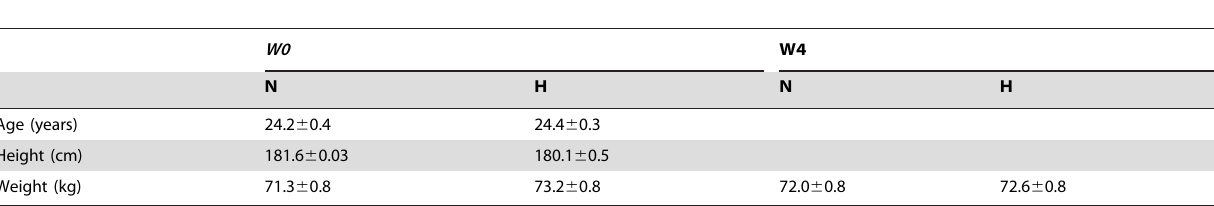
Table 1. The subjects’ physical characteristics of Normoxic (N: n =8) and Hypoxic (H: n =10)